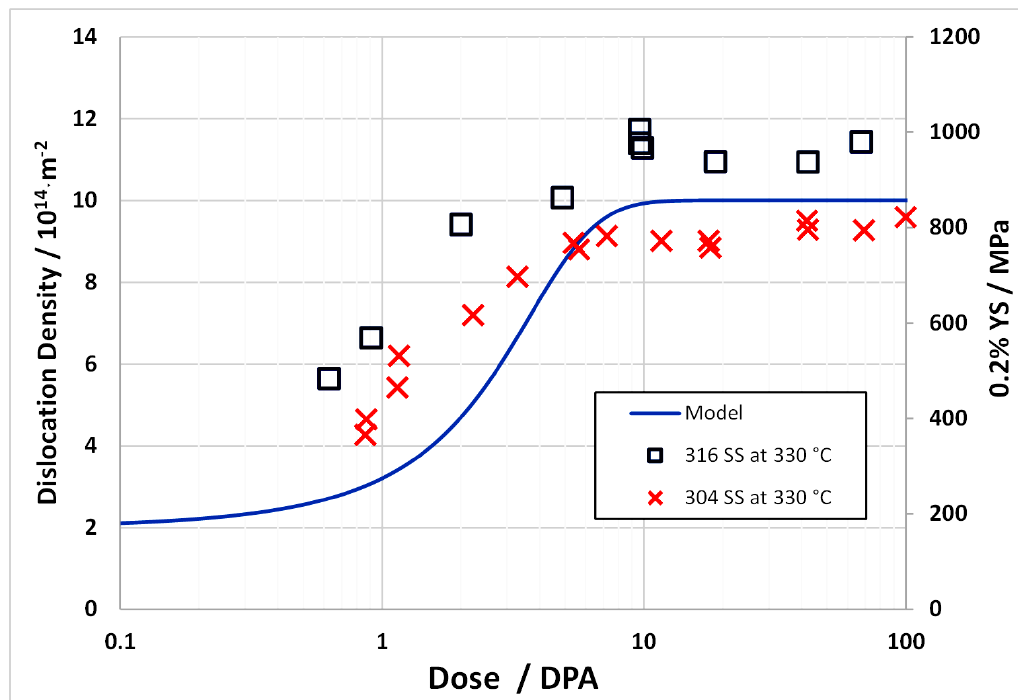
Figure 26. Uniaxial tensile yield stress data used for calculating swelling for austenitic stainless steels (316 SS and 304 SS) irradiated and tested at 330 °C. Modified from [68].